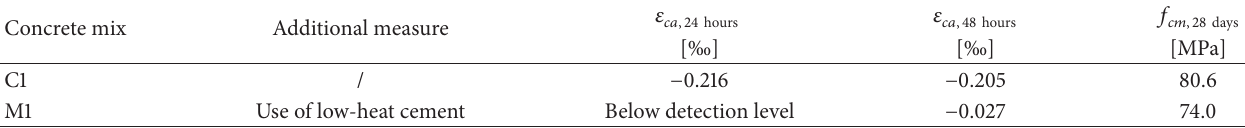
Table 5: Comparison of the autogenous shrinkage of 24- and 48-hour-old concrete which differed according to the type of cement, and their associated 28-day compressive strengths.